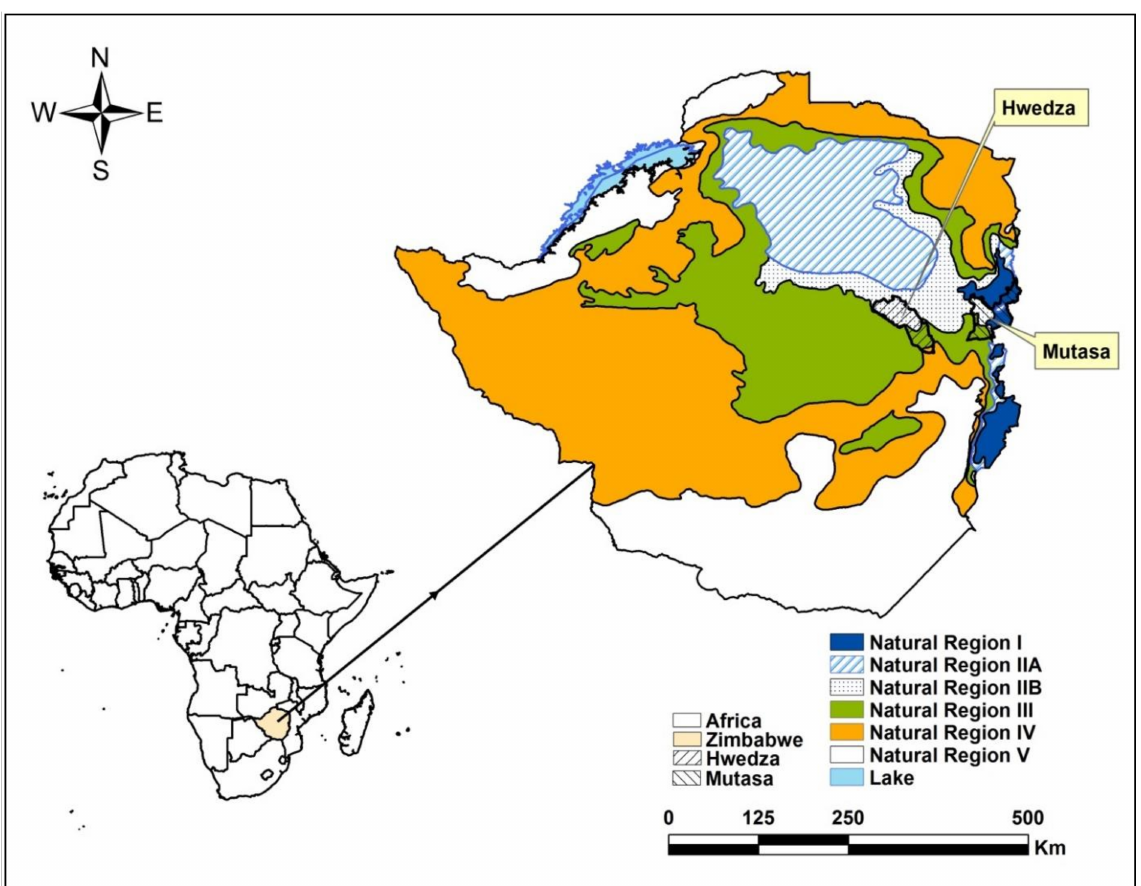
Figure 1. Map showing location of field sites in Hwedza and Mutasa districts where experiments were conducted during the 2016–2018 cropping